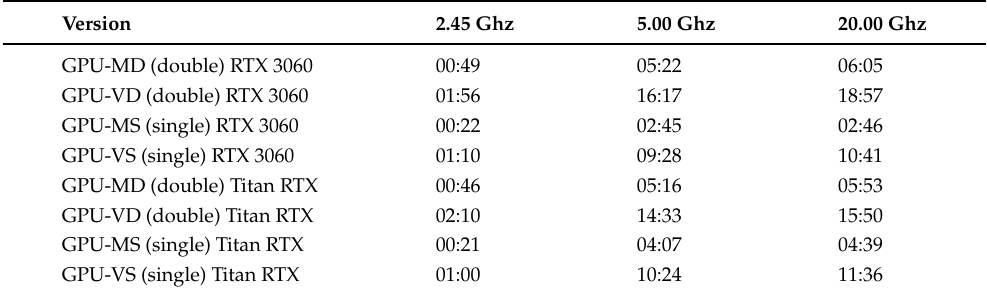
Figure 6. Free space propagation experiment. The orange dot indicates the position of the source, while green dots show the location of the control points. Table 6. Execution times obtained using the RTX 3060 and Titan RTX, expressed in mm:ss, for the free space propagation.